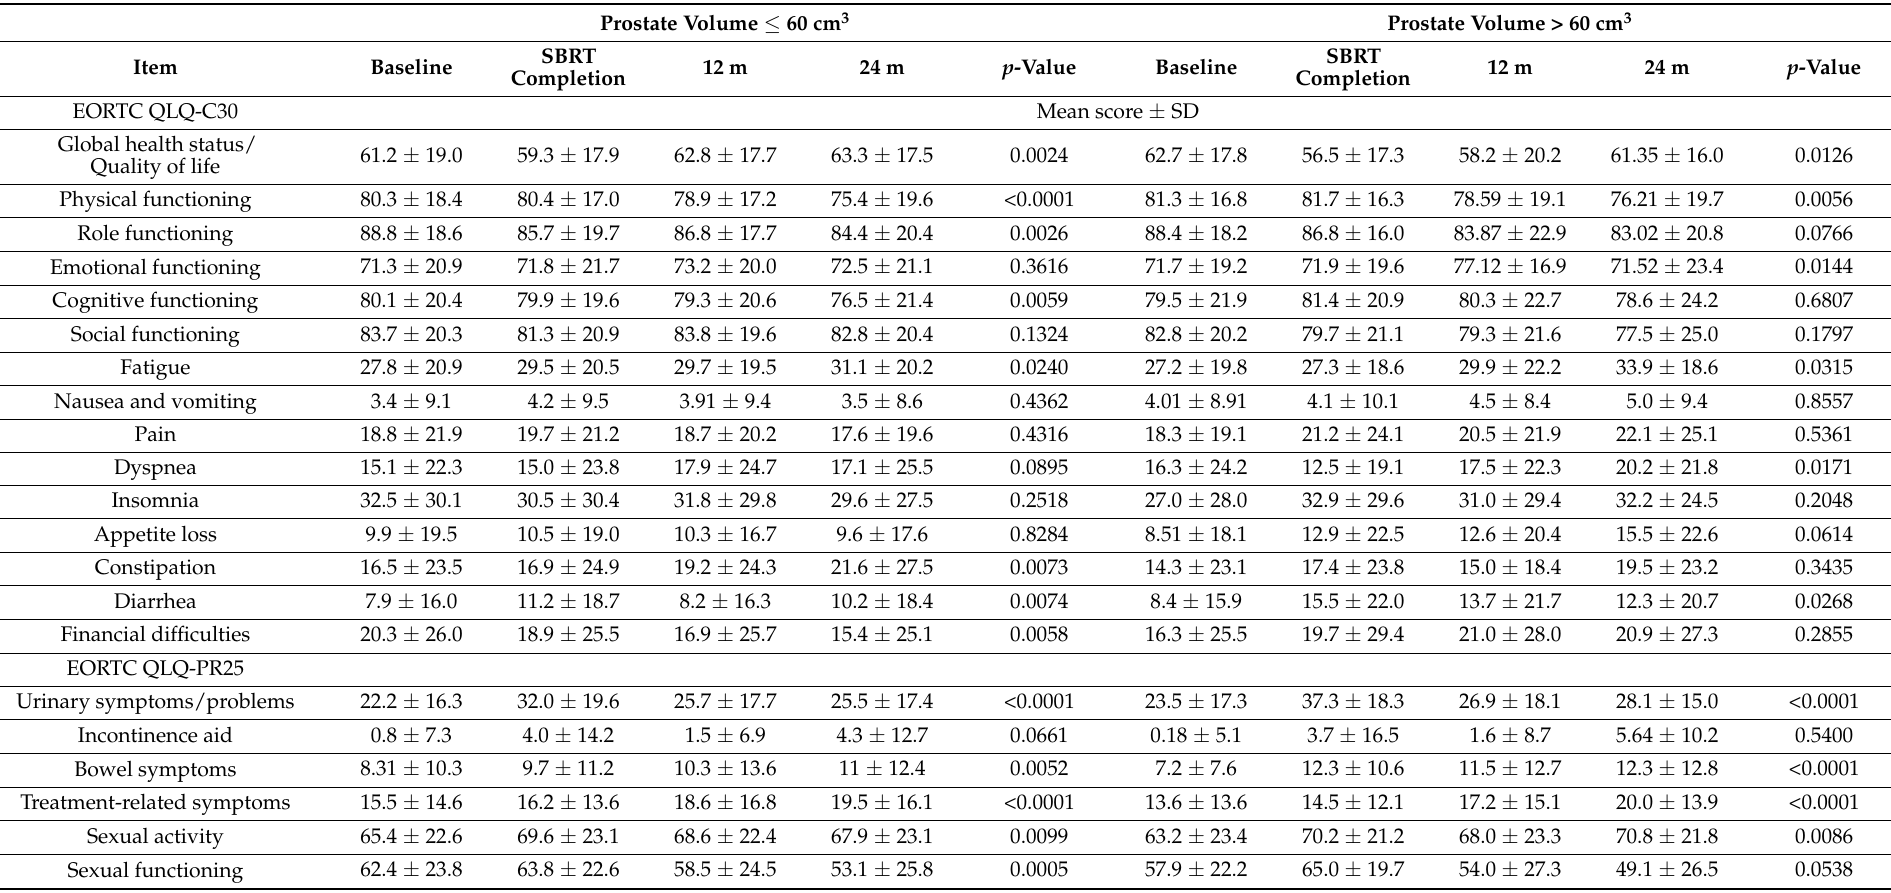
Table 2. EORTC C-30 and PR-25 scores at baseline, completion of SBRT, and at 12- and 24-months post-SBRT according to prostate volume (Repeated ANOVA analysis